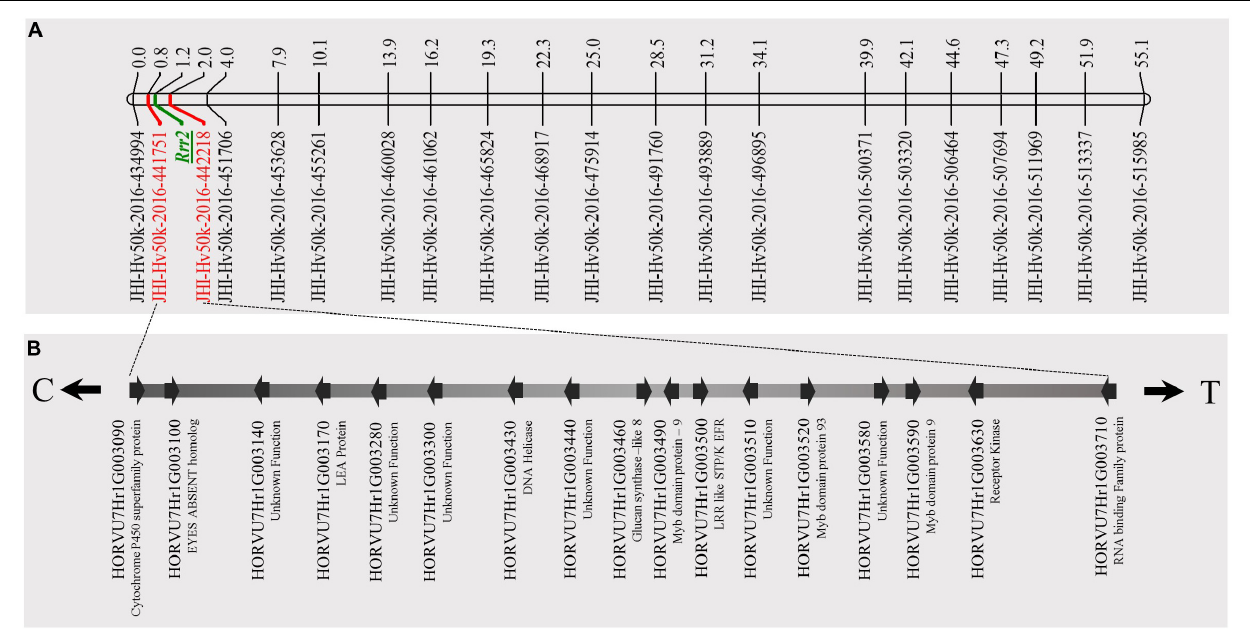
FIGURE 5 | Genetic map of barley chromosome 7H using the barley 50K iSelect SNP array markers and identification of candidate genes for Rrr2 . (A) The genetic map distance of 71 non-co-segregating markers in barley chromosome 7H was computed based on the recombination frequency of 77 Q21861/Pinnacle RMRL-NIL derived using a Kosambi mapping function in MapDisto v.1.7.7.7. The publicly available software MapChart v2.32 was used to draw a linkage map using the obtained genetic map distances. Rrr2 was delimited to a genetic distance of ∼ 1.8 cM between the flanking markers JHI-Hv50K-2016-441751 and JHI-Hv50K-2016-442218. (B) The physical position of the genetic markers flanking Rrr2 were used to identify seventeen high-confidence annotate genes from the IBSC RefSeq v1.0 of barley cv. Morex genome (http://webblast.ipk-gatersleben.de/barley_ibsc/downloads/). C and T at the end of the horizontal line indicate the direction of centromere and telomere,